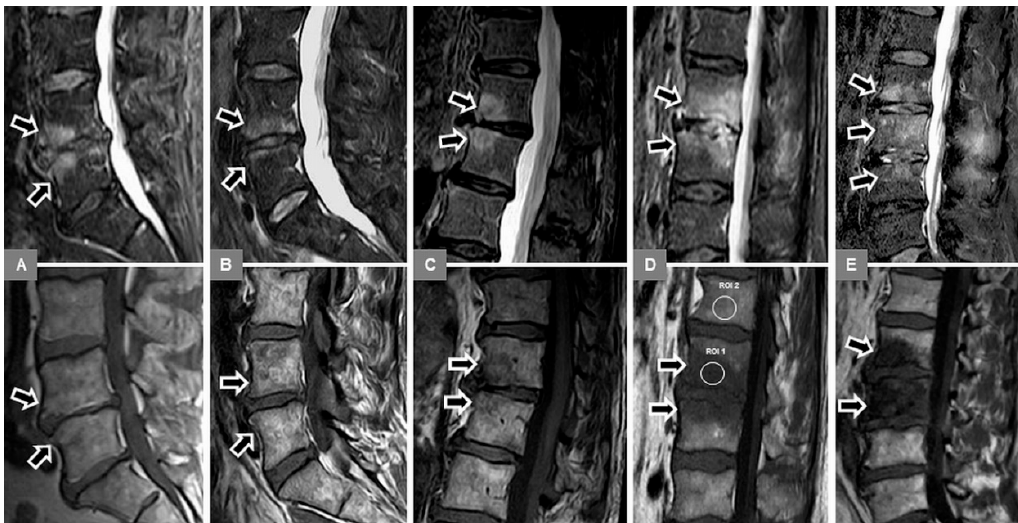
Figure 4. Visual assessment of the T1-w signal (bottom row of sagittal T1-w images, arrows), corresponding to the bone marrow edema (top row of sagittal STIR images, arrows), compared to normal bone marrow, in different patients with MT1 or spondylodiscitis. ( A ) A 53-year-old female patient with Modic type 1 and a hyperintense T1-signal at L4/5. This signal hyperintensity is explained by the overlap of bone marrow edema and fatty marrow conversion, thus additional Modic type 2 changes. ( B ) A 53-year-old female patient with Modic type 1 and isointense T1-signal at L4/5. ( C ) A 78-year-old female patient with Modic type 1 and mixed hyper-/hypointense T1-signal at Th12/L1. ( D ) A 63-year-old male patient with early spondylodiscitis and hypointense T1-signal (equal to the musculature) at L2/3. The region of interest (ROI) (1) at L2 exemplifies the measurement of the T1-signal intensity within the bone marrow edema area, and the ROI (2) within the adjacent unaffected vertebral body at L1. ( E ) A 66-year-old male patient with early spondylodiscitis and marked hypointense T1-signal (more hypointense than the musculature) at L2/3.